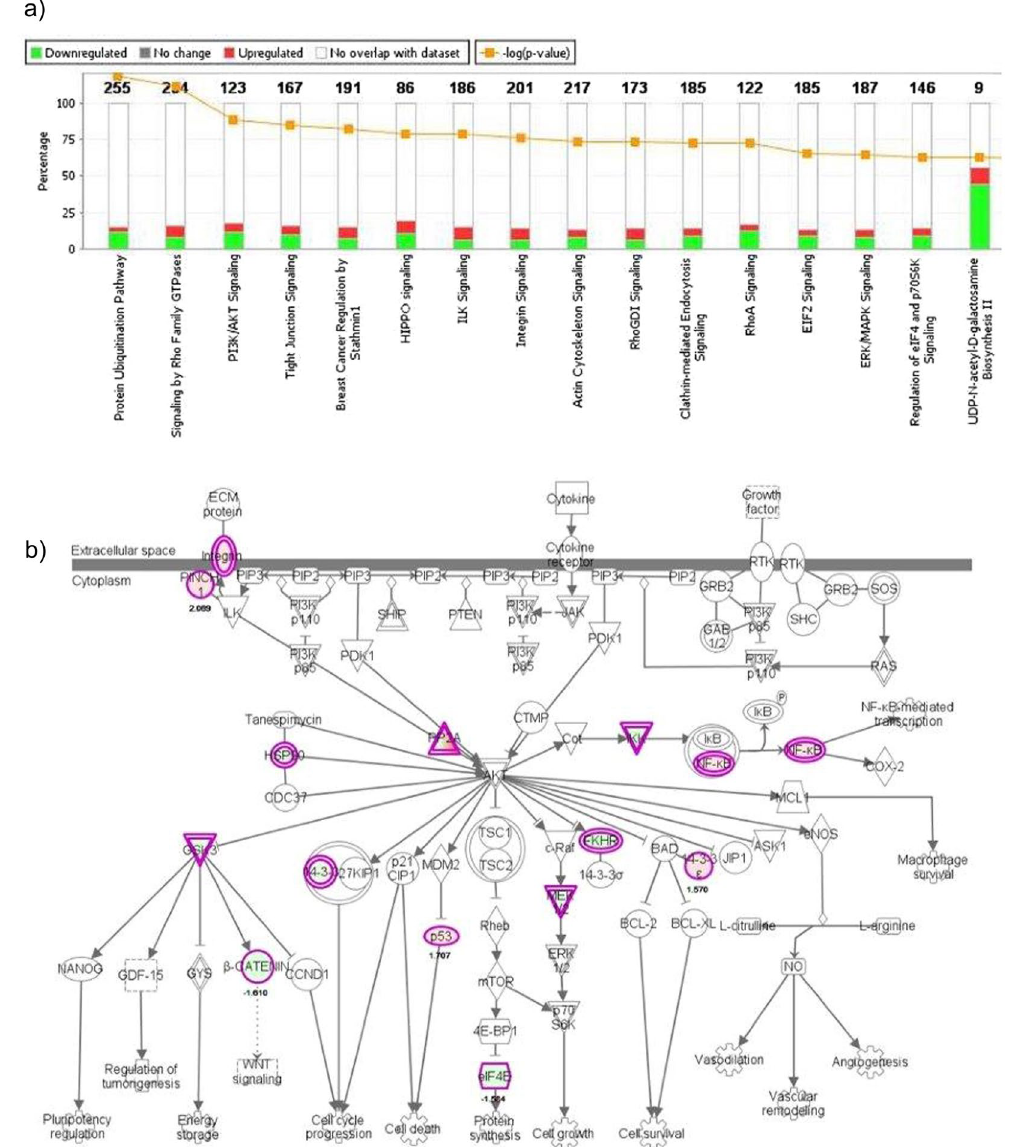
Figure 5. Proteomic analysis of H1975GP and H1975GR cell lines. Protein was isolated from H1975GP and H1975GR cell lines and analysed by bottoms-up label-free mass spectrometry, in order to identify differences in protein abundance (n = 3). 1173 proteins were significantly (p < 0.05) differentially regulated (fold change > 2) between parent and GDC-0980 resistant cells. Data was analysed using Ingenuity Pathway Analysis. ( a ) Top dysregulated pathways are shown. ( b ) Differential regulation is shown in the context of the PI3K